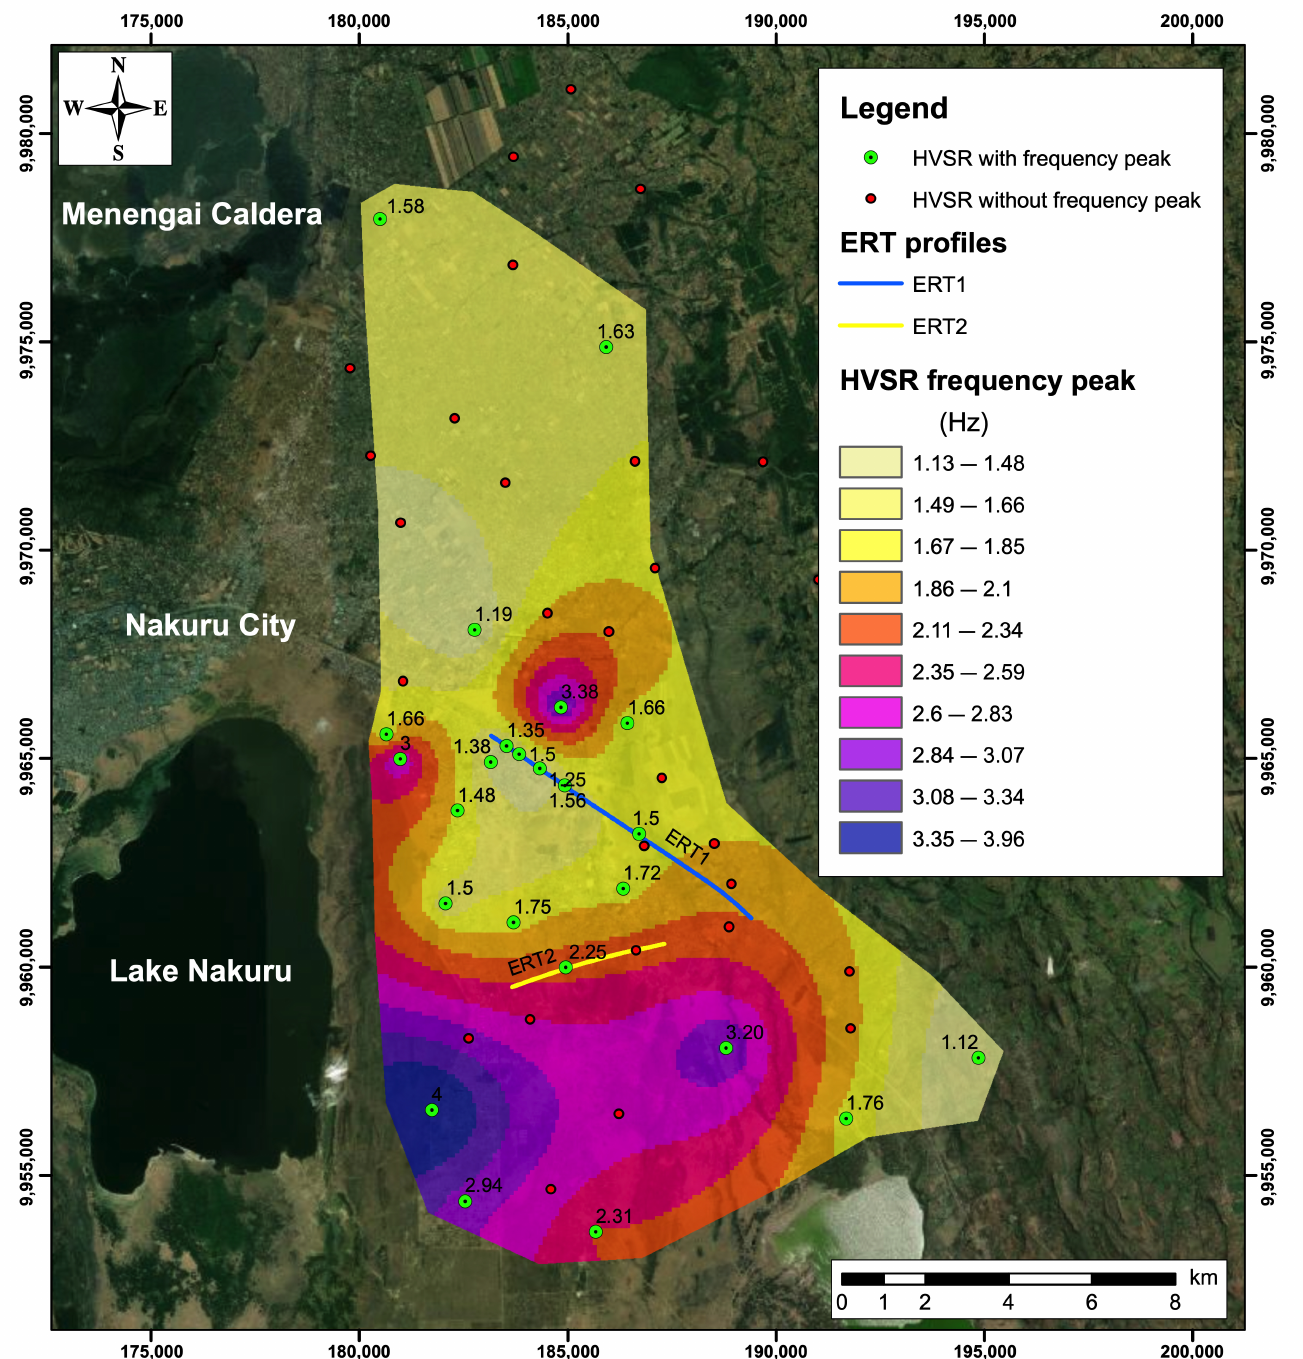
Figure 9. Frequency map for the study area, based on HVSR data. ERT lines are